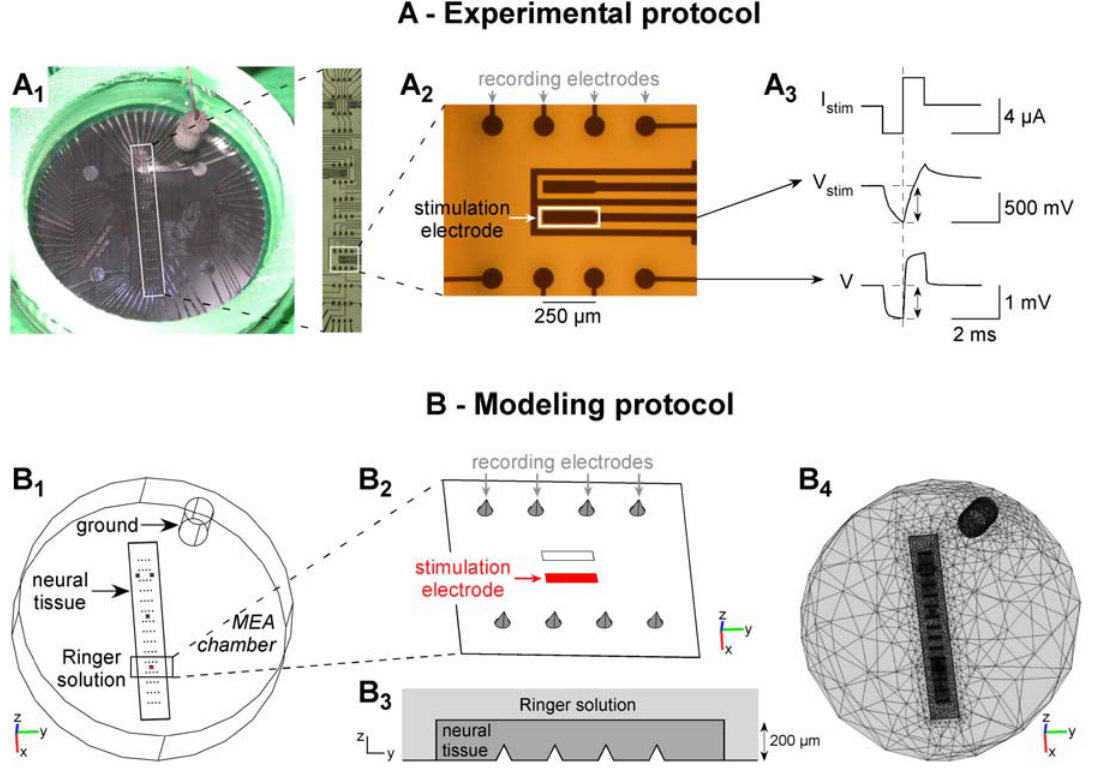
Figure 1. Experimental (A) and modeling (B) stimulation paradigms. A : Top view of the experimental MEA chamber (A1). The ‘‘spinal MEA’’ from Ayanda BioSystems consists of 4 6 15 3D recording electrodes (arrows in A2) and 8 2D stimulation electrodes (rectangles in A2). Current- controlled monopolar stimulations were applied between a 2D stimulation electrode and an external cylindrical Ag/AgCl ground electrode. The potential field V generated in the medium was measured by the 60 recording microelectrodes, and the stimulation electrode voltage ( V metal = V stim ) was recorded with a home-made follower circuit. Peak values were measured at the end of the cathodic phase of the pulse stimulus (see example in A3). B : Top view of the 3D finite element model used for the computation of the potential field. The 60 recording electrodes were modeled by cones, and the stimulation electrode by a 2D rectangular surface on the substrate (B2). All these electrodes were represented as surface boundaries in the finite element model. When present, the neural tissue was modeled as a 200- m m-thick parallelepiped with a different electrical conductivity than that of the Ringer solution (B3). The 3D mesh consisted of 63,214 tetrahedral Lagrange P2 elements, corresponding to 101,105 degrees of freedom (B4).